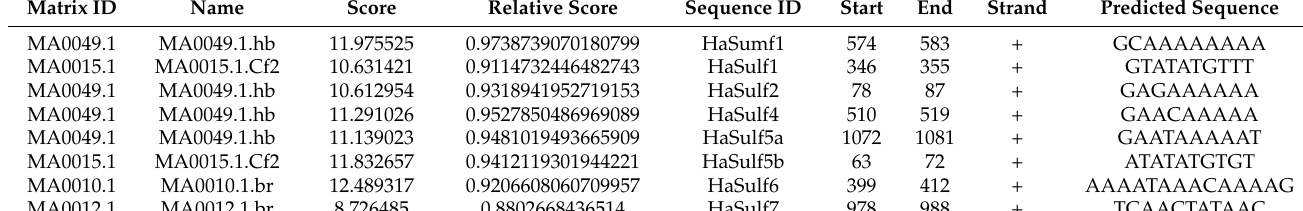
Table 4. Promoter transcription binding site prediction.